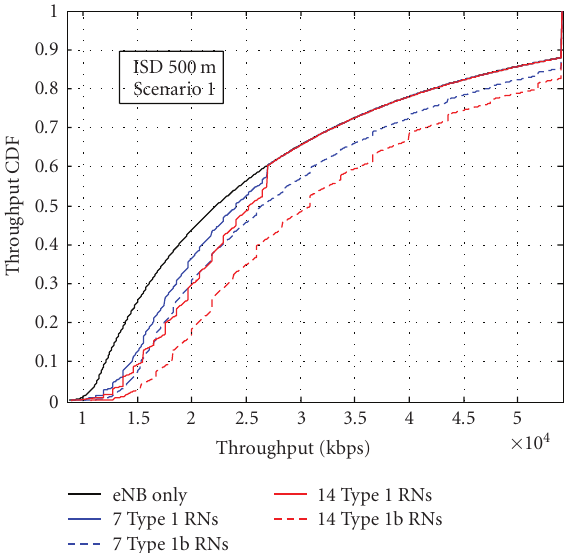
Figure 5: Throughput CDF-Scenario 1, ISD 500 m.